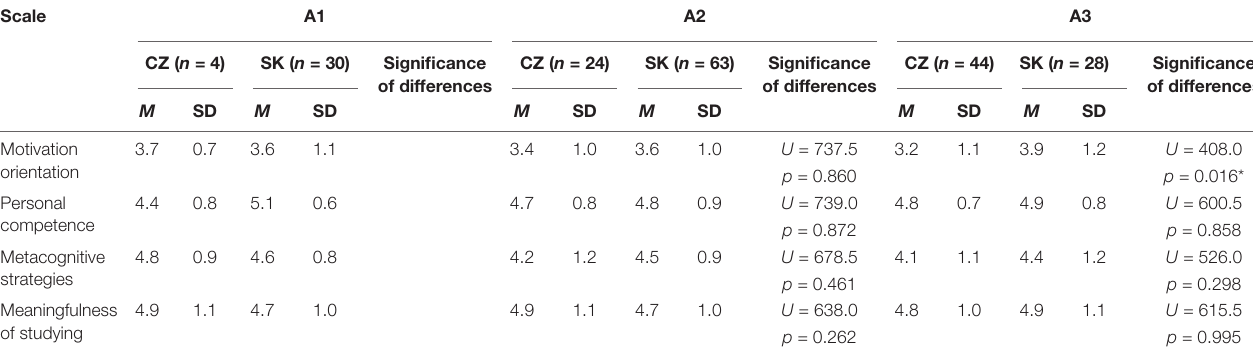
TABLE 5 | An overview of the analysis by age.